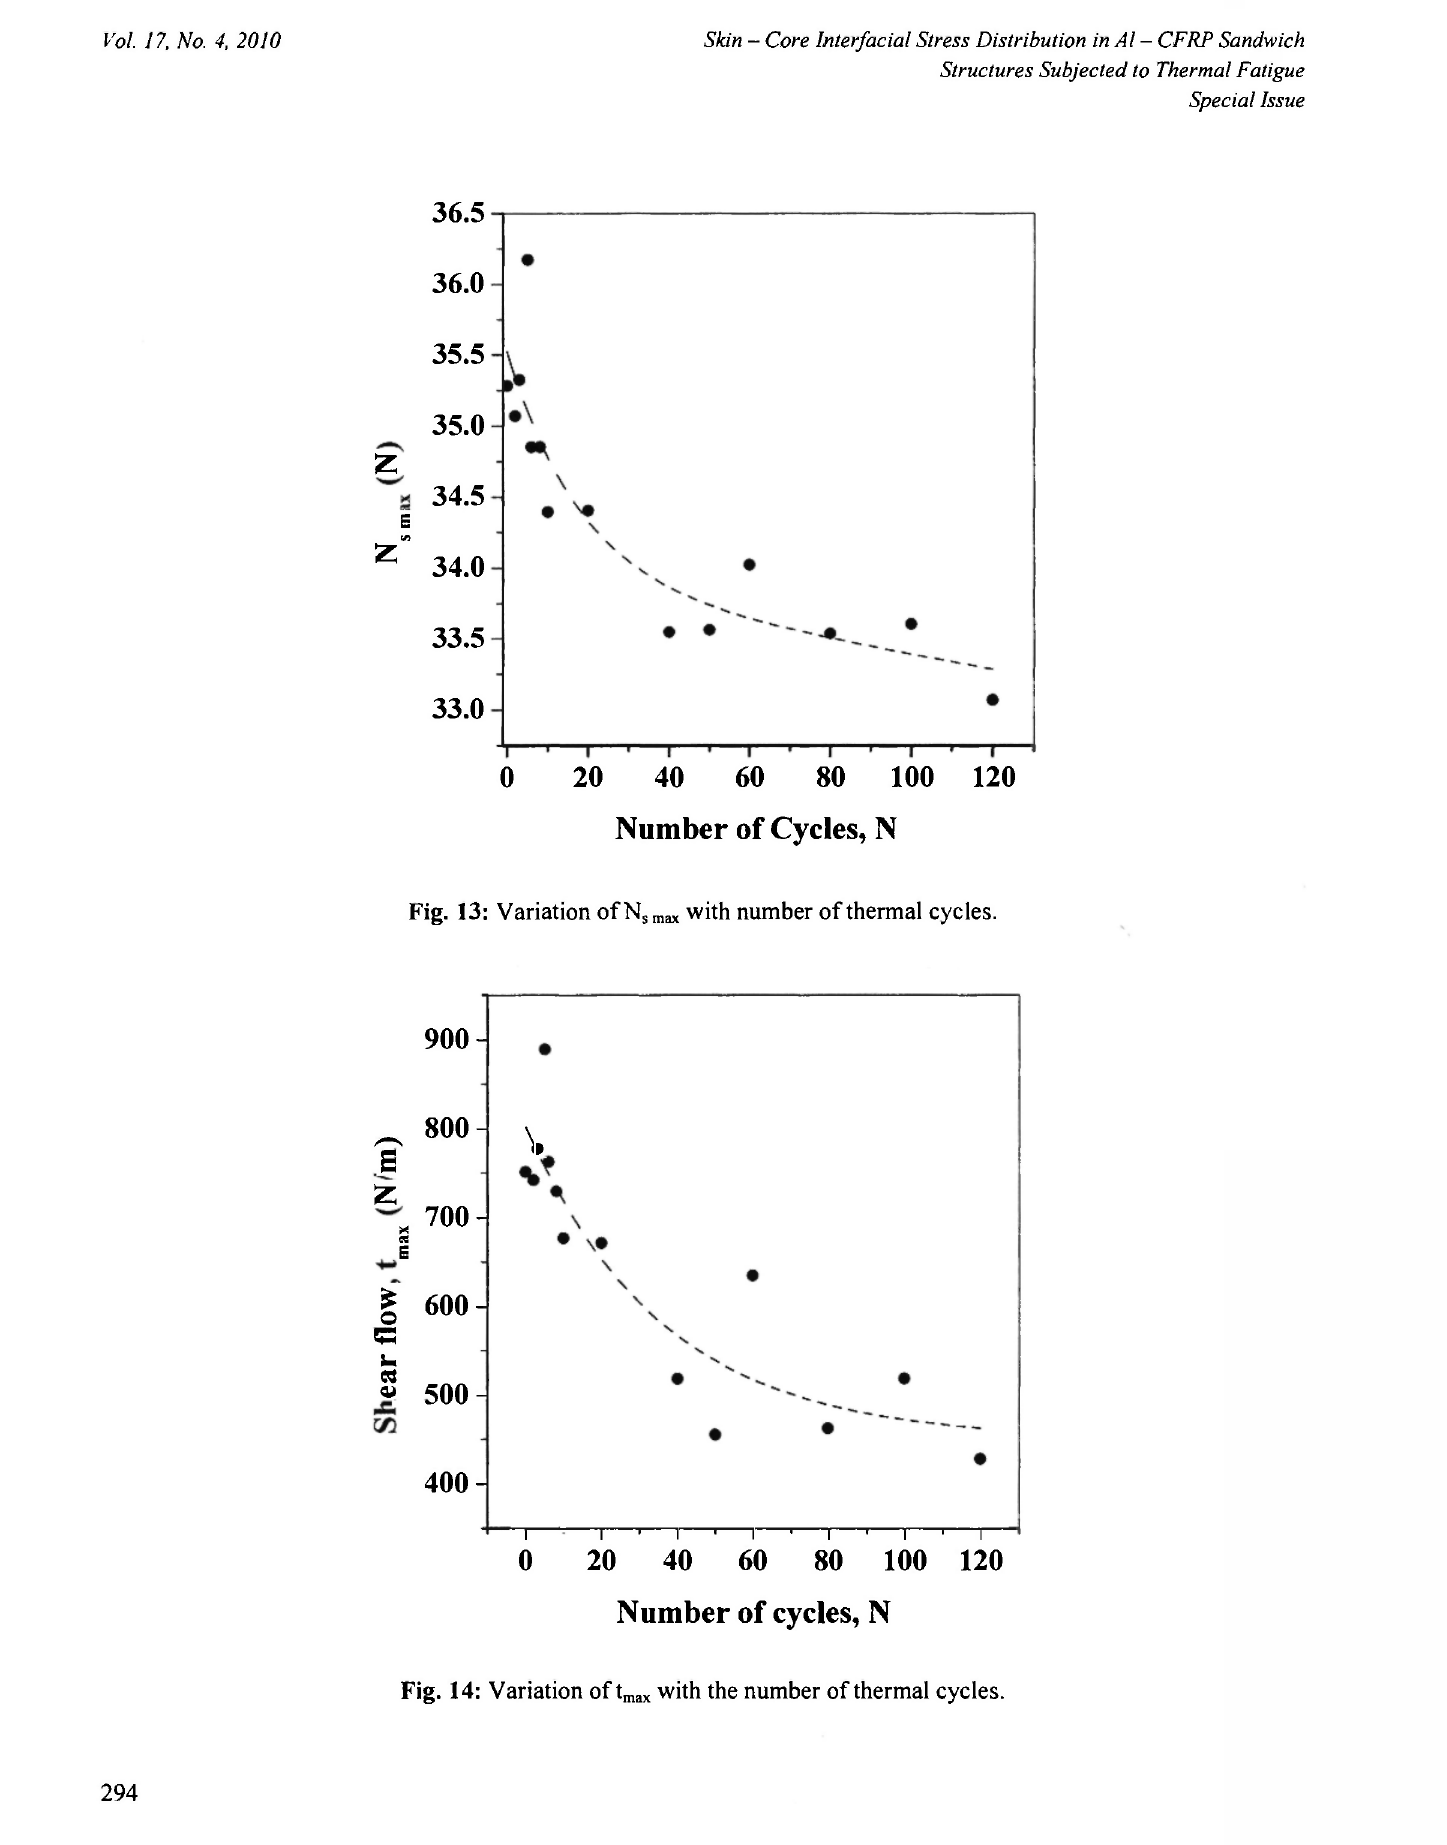
Fig. 14: Variation of t max with the number of thermal